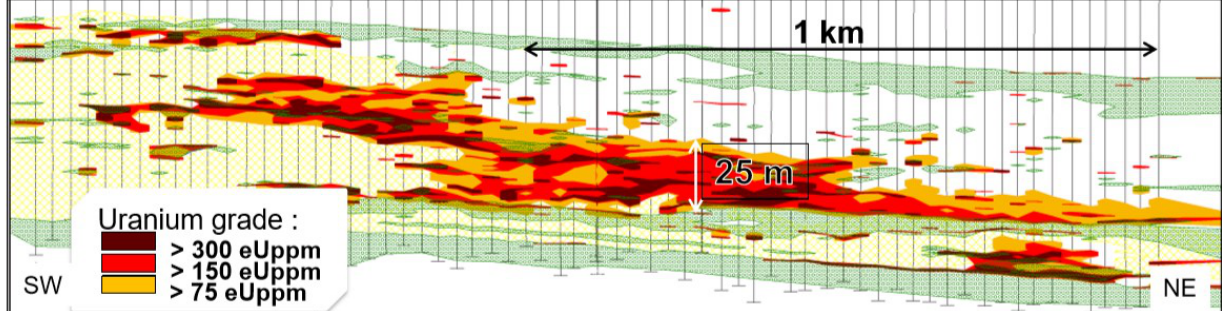
Fig. 2. Schematic cross section and distribution of uranium of Zuuvch ovoo deposit (After